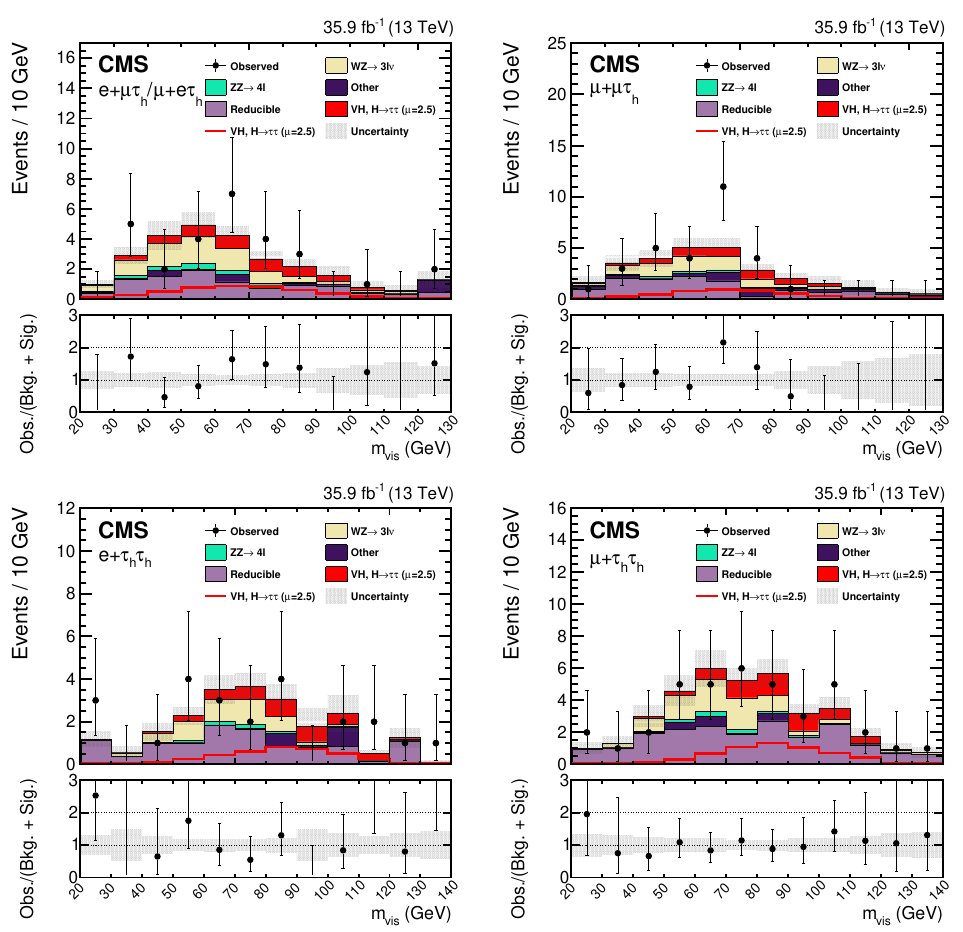
Figure 3 . Post-(cid:12)t visible mass distributions of the Higgs boson candidate in the e + (cid:22)(cid:28) h / (cid:22) + e (cid:28) h (upper left), (cid:22) + (cid:22)(cid:28) h (upper right), e+ (cid:28) h (cid:28) h (lower left), and (cid:22) + (cid:28) h (cid:28) h (lower right) (cid:12)nal states. The uncertainties include both statistical and systematic components. The WH and ZH, H ! (cid:28)(cid:28) signal processes are summed together and shown as VH, H ! (cid:28)(cid:28) with a best (cid:12)t (cid:22) = 2 : 5. VH, H ! (cid:28)(cid:28) is shown both as a stacked (cid:12)lled histogram and an open overlaid histogram. The contribution from \Other" includes events from triboson, tt+W/Z, ttH production, and all production modes leading to H ! WW and H ! ZZ decays. In these distribution the WH, H ! (cid:28)(cid:28) processes contributes 91{93% of the total of VH, H ! (cid:28)(cid:28) .